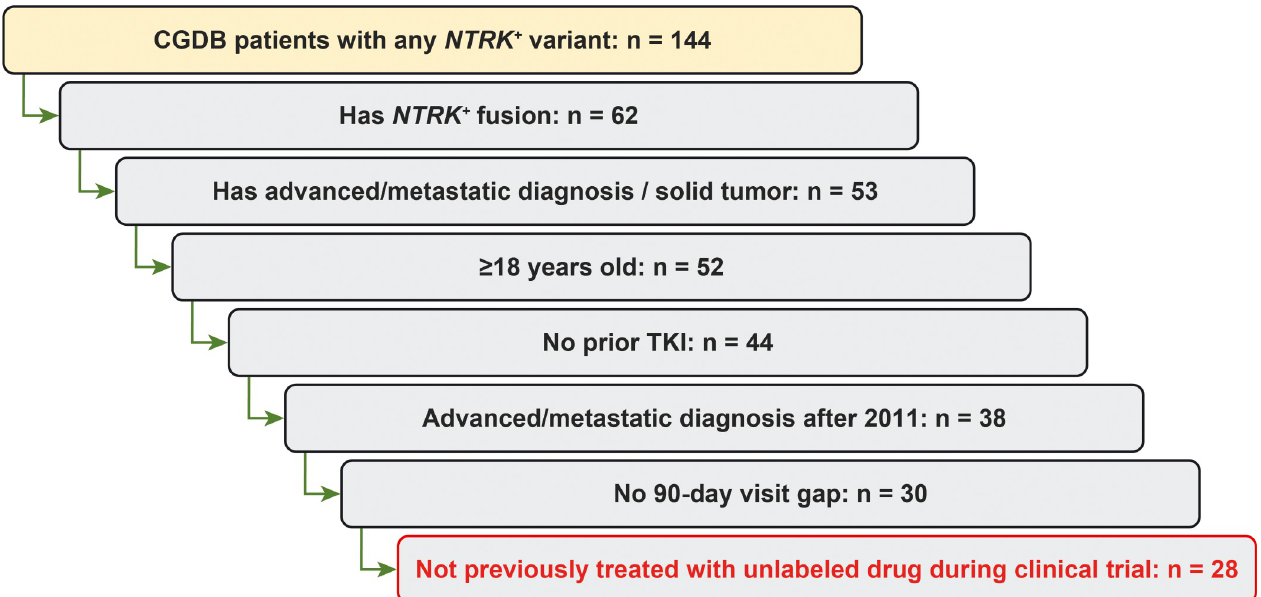
Fig 1. Cohort attrition. Abbreviations: CGDB, clinicogenomic database; NTRK + , neurotrophic tropomyosin receptor kinase fusion-positive; TKI, tyrosine kinase inhibitor.